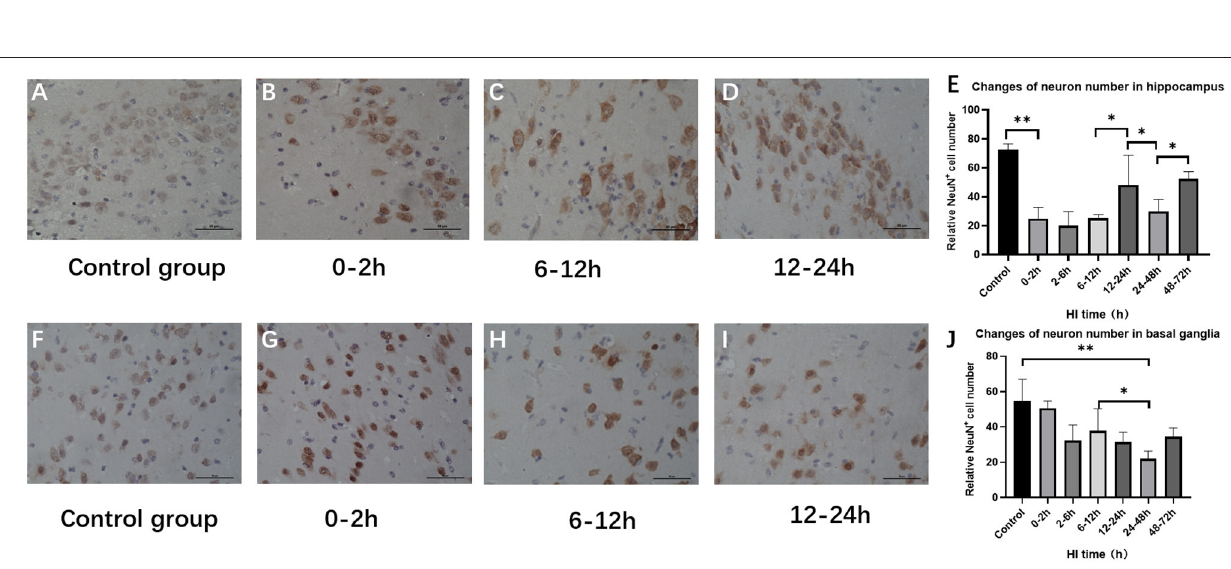
Frontiers in Neuroanatomy |